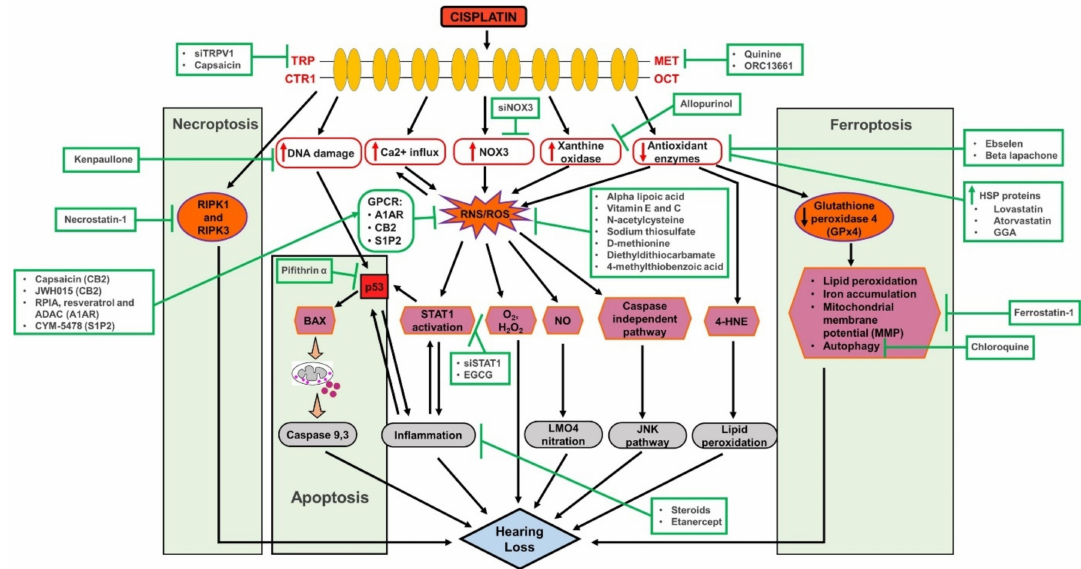
Figure 1. Comprehensive figure of cisplatin ototoxicity and potential targets for otoprotection. Cisplatin entry through several membrane sites including MET (mechanoelectrical transduction), TRP (transient receptor potential) and OCT (organic cation transporters) channels. Several mechanisms of cisplatin ototoxicity are listed, namely the generation of ROS via NOX3, leading to the activation of lipid peroxidation, DNA damage, inflammation and cell death pathways. Several potential targets for otoprotection include inhibition of drug entry (via MET channels), scavenging of ROS (using antioxidants), inhibition of inflammation (using anti-inflammatory drugs) and inhibition of apoptosis (using p53